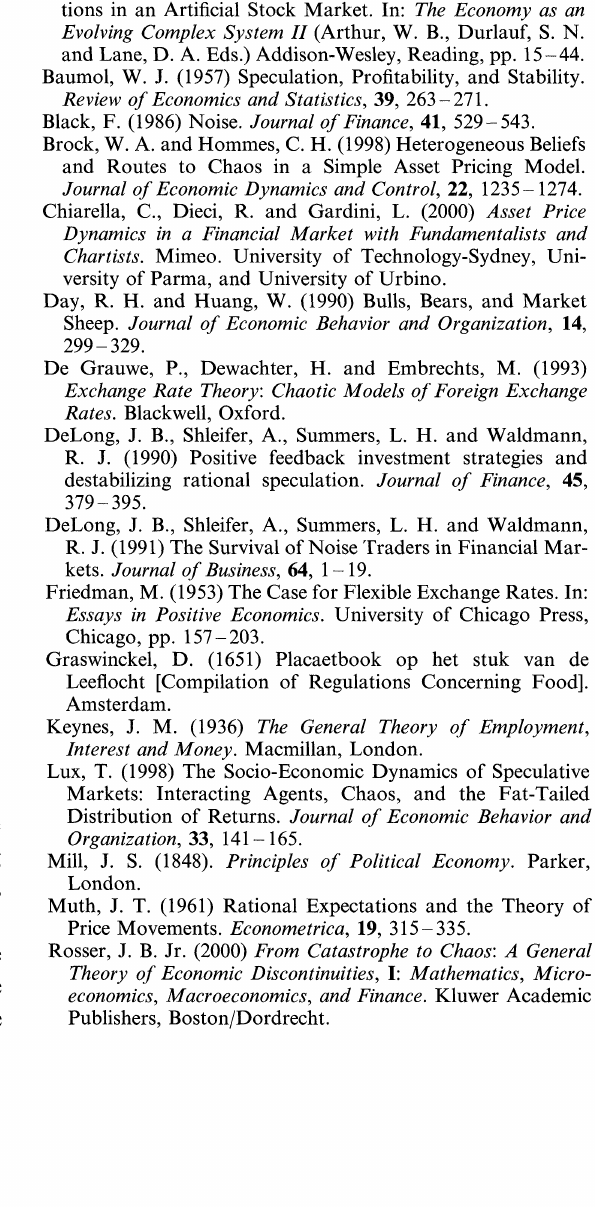
FIGURE 15 Moving average length and bifurcation of price